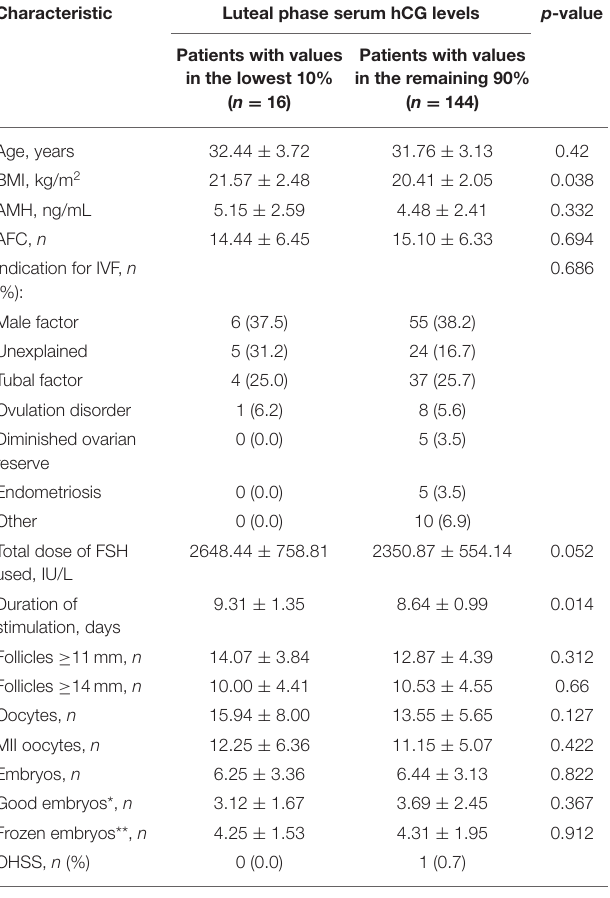
TABLE 2 | Baseline, cycle and stimulation characteristics in subjects with the lowest 10% of early luteal phase human chorionic gonadotropin (hCG) values vs. patients with luteal phase hCG levels in the remaining 90%.